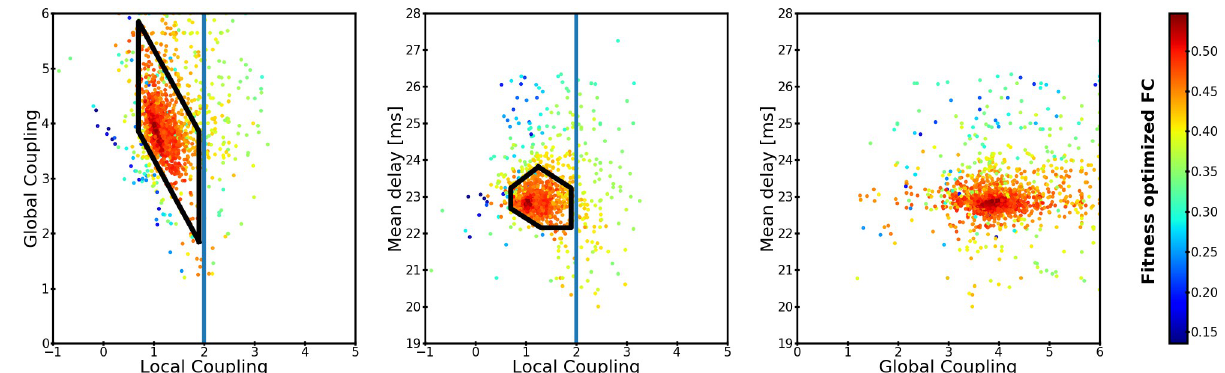
Fig 2. Similarity between simulated and MEG sFC during the optimization with homogeneous ensembles. Each dot represents the correlation between simulated and empirical MEG sFC during one evaluation of the fitness function. A three-dimensional parameter space consisting of global coupling, local coupling, and mean delay (proportional to spike-conductance velocity) is optimized for reproduction of the empirical sFC. Each panel has one dimension collapsed over the two axes. Simulations outside of the optimization constraints are not shown. The black area indicates the area of the parameter space that is further analyzed for trFC. Only the parameter combinations which produced dynamics within the biological constrains are shown.